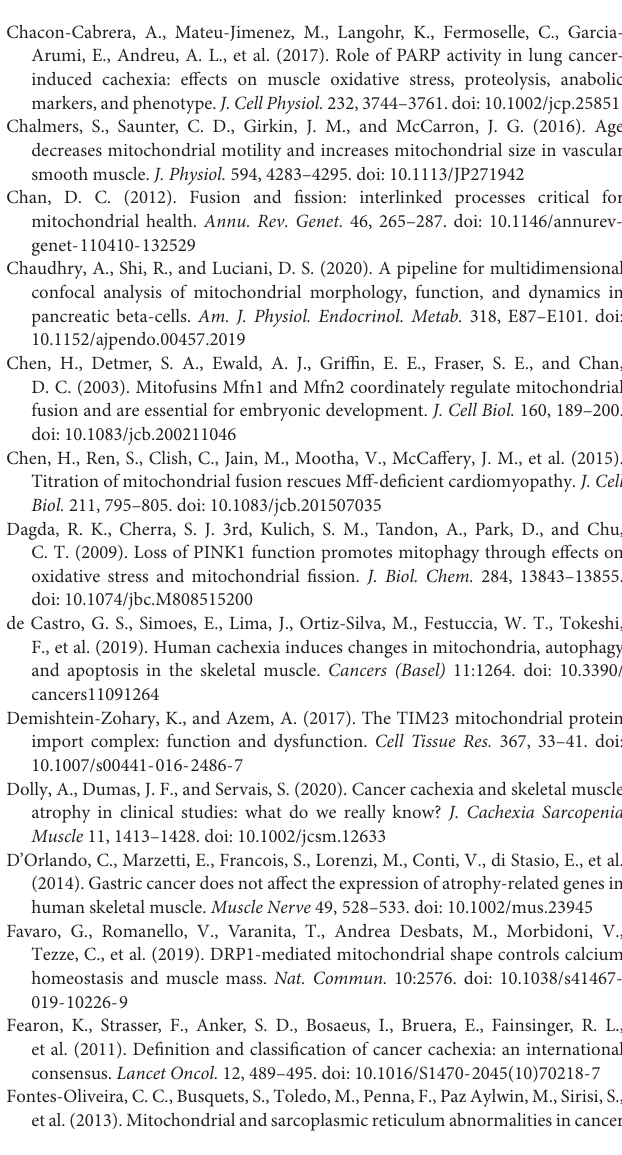
Supplementary Figure 2 | (A) Typical images to analyze fluorescence intensity of eGFP in myoblast. (B) Level of DRP1, GAPDH by western blot. (C) Quantification of (B) ∗ P < 0.05 Vc (myoblast infected with control lentivirus), OE (myoblast infected with overexpressed lentivirus), KD (myoblast infected with knockdown lentivirus). Control: myotube cultured in DMEM of 2% HS CM (conditional medium): myotube cultured in DMEM of 33% C26 conditional medium; ∗ P <